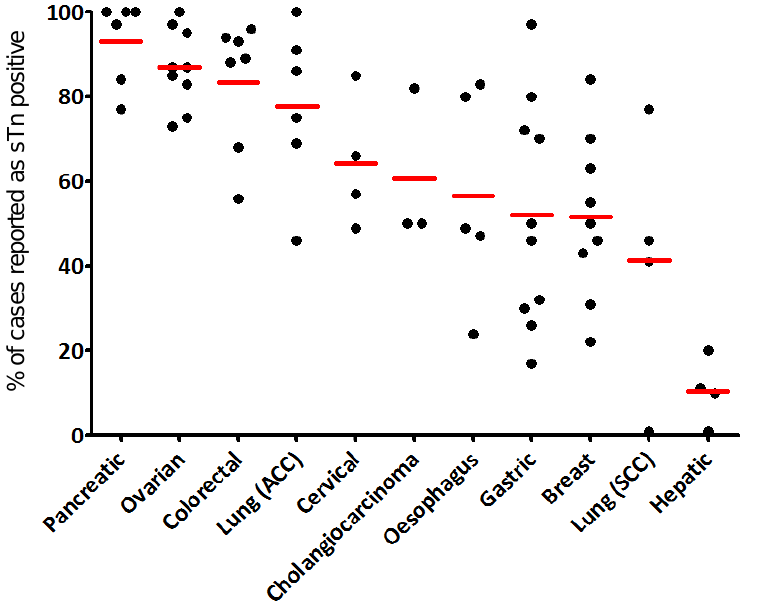
Figure 2. STn frequency in the most studied cancers. Each dot represents a report (see Figure 3 for references). The red bar is the mean of the percentage of STn positive